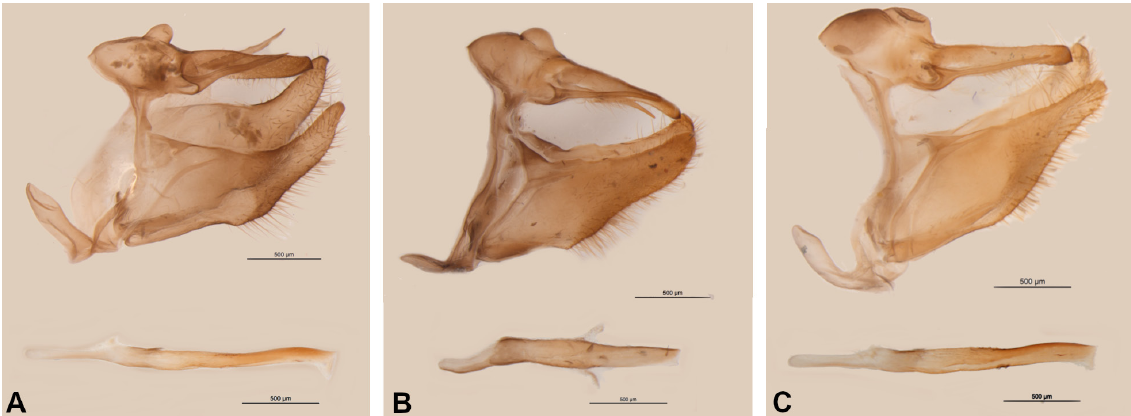
Fig. 5. Zischkaia “ saundersii clade”, male genitalia. A . Z. saundersii (Butler, 1867), ♂, lateral view, with phallus separated (Genitalic vial: DZ 21. 221). B . Z. mielkeorum Dolibaina, Dias & Zacca, sp. nov., ♂, lateral view, with phallus separated (Genitalic vial: DZ 21. 200). C . Z. warreni Dias, Zacca & Dolibaina, sp. nov., ♂, lateral view, with phallus separated (Genitalic vial DZ 21.